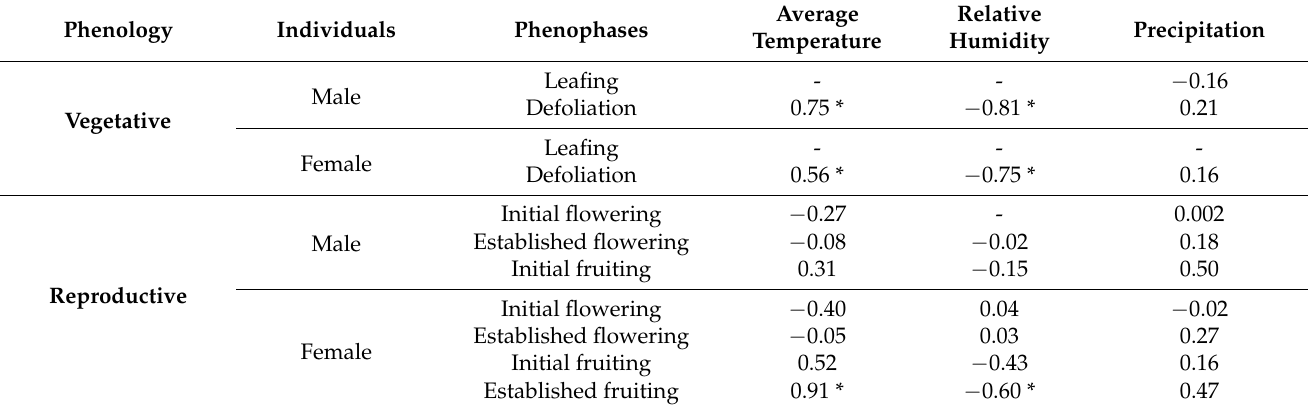
Table 1. Spearman correlation between the climatic variables (average temperature ( ◦ C), relative air humidity (% UR), and precipitation (mm); recorded between September 2015 and August 2016) and the intensity of vegetative (leafing and defoliation) and reproductive (buds, flowers, immature and mature fruits) phenophases of individuals of D. sericea